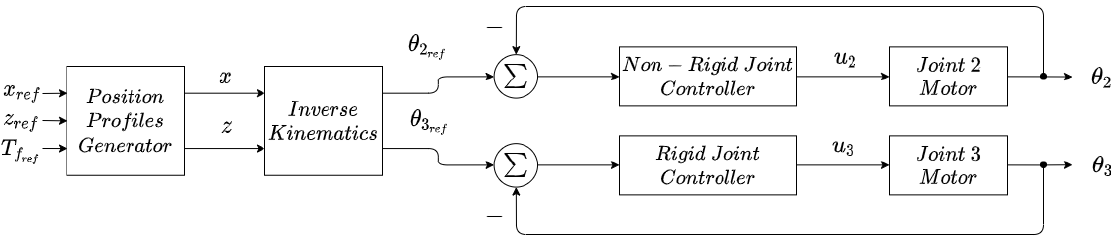
Figure 15. Complete control block